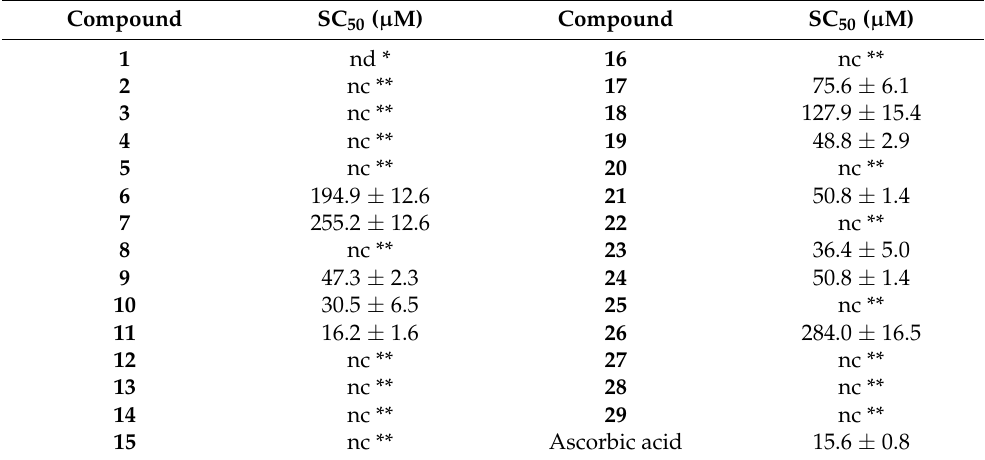
Table 3. Antioxidant activities of compounds and positive control in DPPH radical scavenging assay.